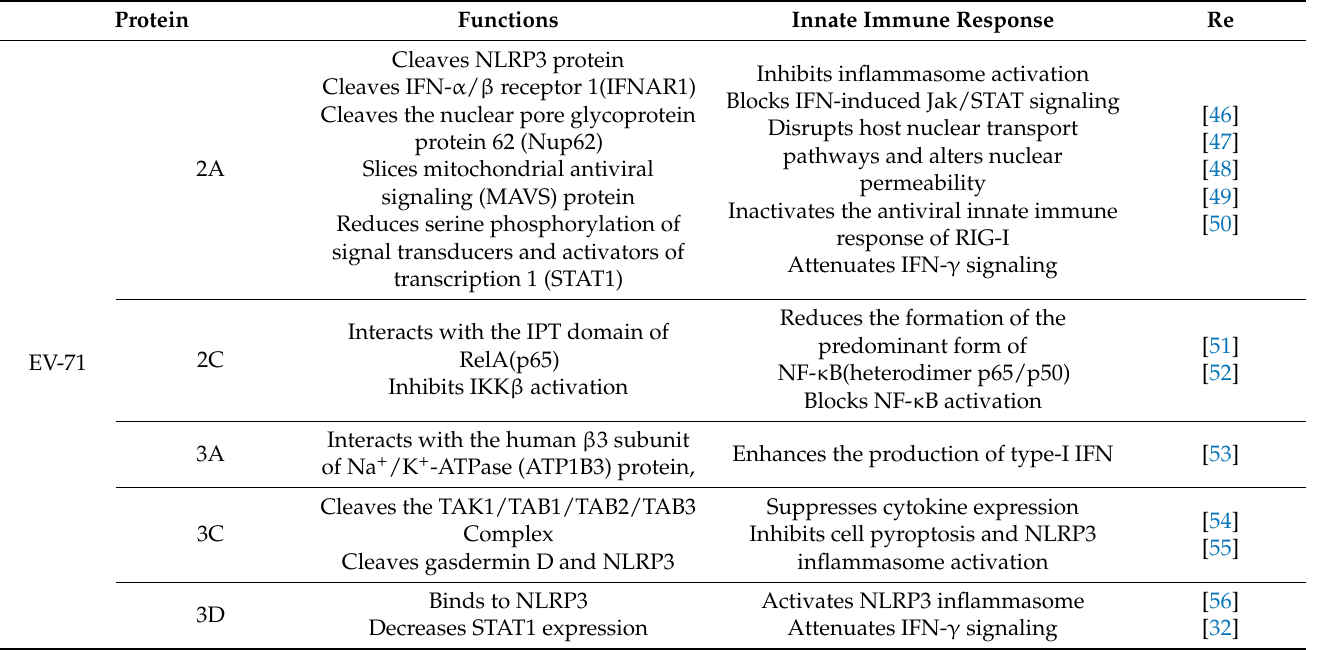
Table 1. Native immune response induced by HFMD-associated enterovirus nonstructural proteins. Protein Functions Innate Immune